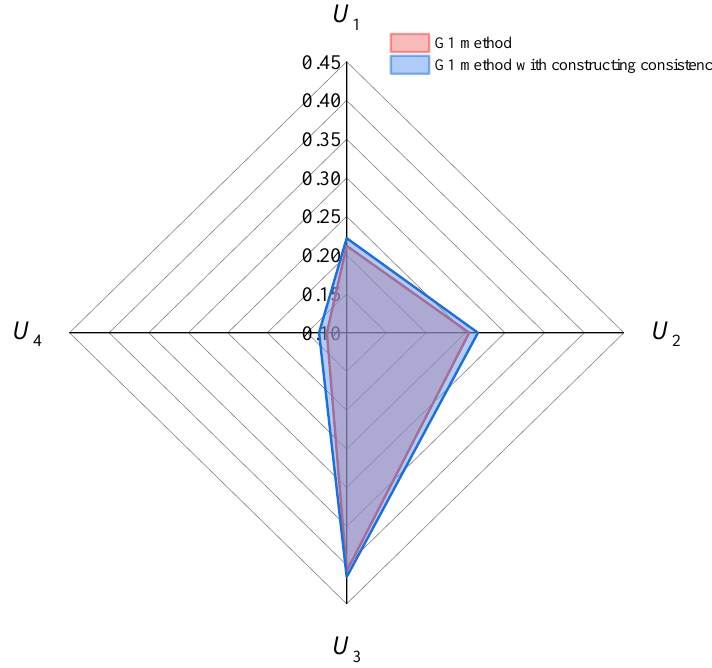
Figure 2. Secondary indicators weight calculation results of both methods.